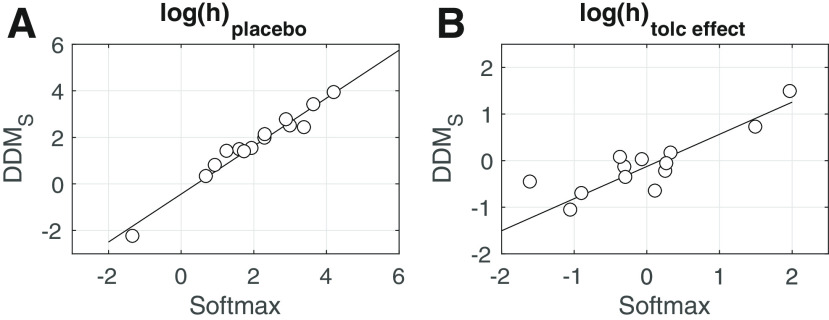
A, Correlation between the probability discount rate log(h) under placebo, estimated via standard softmax and via the DDMS. B, Correlation between the change in log(h) under tolcapone, estimated via standard softmax and via the DDMS.